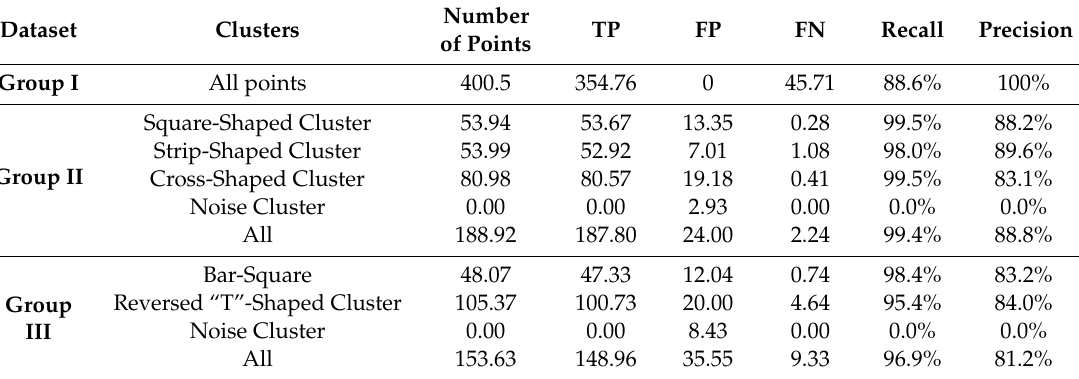
Figure 8. Detection results from the simulations. ( a ) repulsion; ( b ) repulsion and noise; ( c ) aggregation, repulsion and noise. Table 1. Detection results for synthetic data.